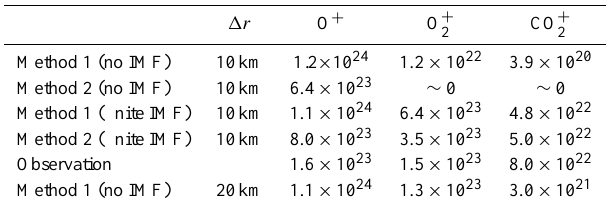
Table 2. List of the ion escape flux [s − 1 ]. The ion escape fluxes of the observation were taken from Barabash et al.